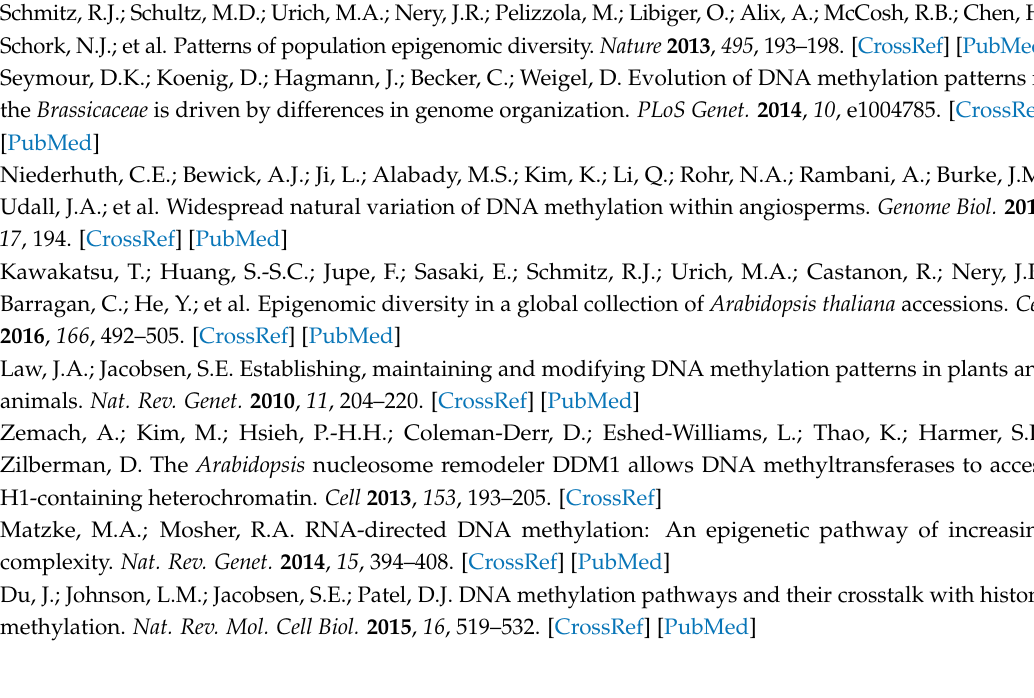
Figure S1: DNA methylation at parental strains, Figure S2: Level of region 1 DNA methylation in parents, F1, and F2, Figure S3: Level of region 2 DNA methylation in parents, F1, and F2, Figure S4: Small RNA expression at parental strains, Figure S5: DNA methylation of region 1 in mutant lines, Figure S6: DNA methylation of region 2 in mutant lines, Table S1: Primers used in the amplicon-Seq, Table S2: Position and motif (CpG, CpHpG, and CpHpH) in analyzed sequence, Table S3: Mapped data of bisulfite amplicon-Seq, Table S4: Genotype of F2 populations, Table S5: Level of DNA methylation, Table S6: BLASTN search of region 1 & 2 in nuclear genome, Supplementary File 1: Sequences of analyzed regions, Supplementary File 2: Commands of data